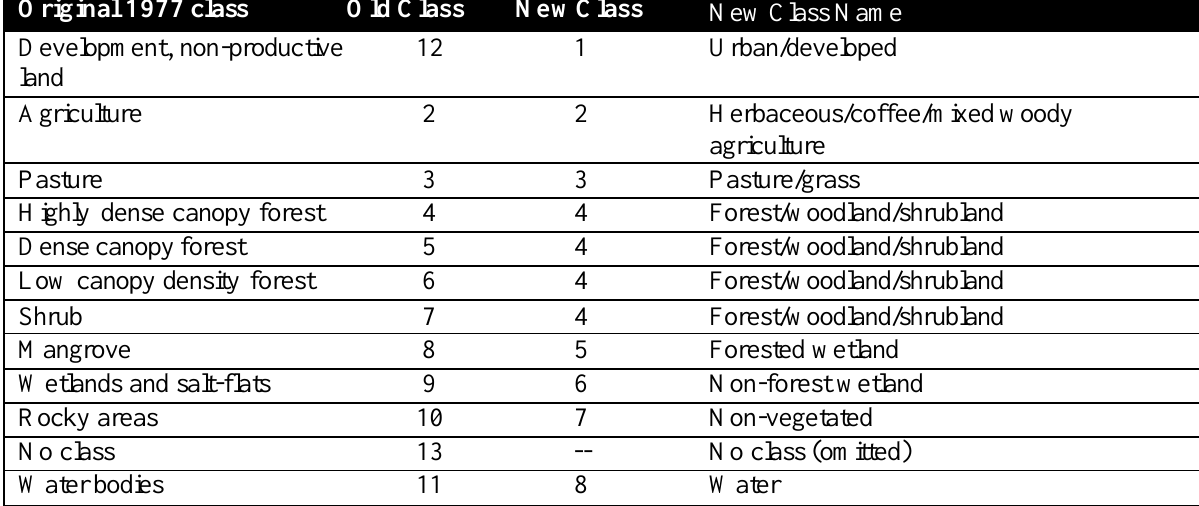
Table A1 : Class conversions from the original 1977 map to the classifications used in our analyse s. The twelve land-cover classes in the 1977 land-cover map discussed by Ramos and Lugo (1994) were reduced to eight classes in our analysis, following the same methodology as Crk et al .